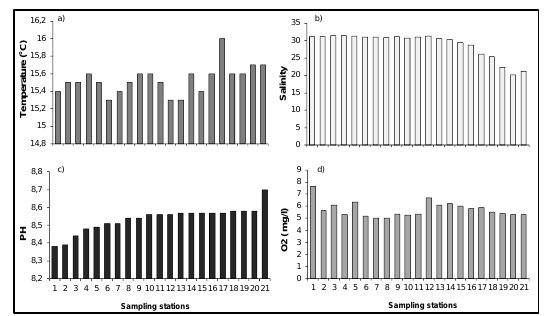
Figure 2. Spatial distribution of Physicochemical